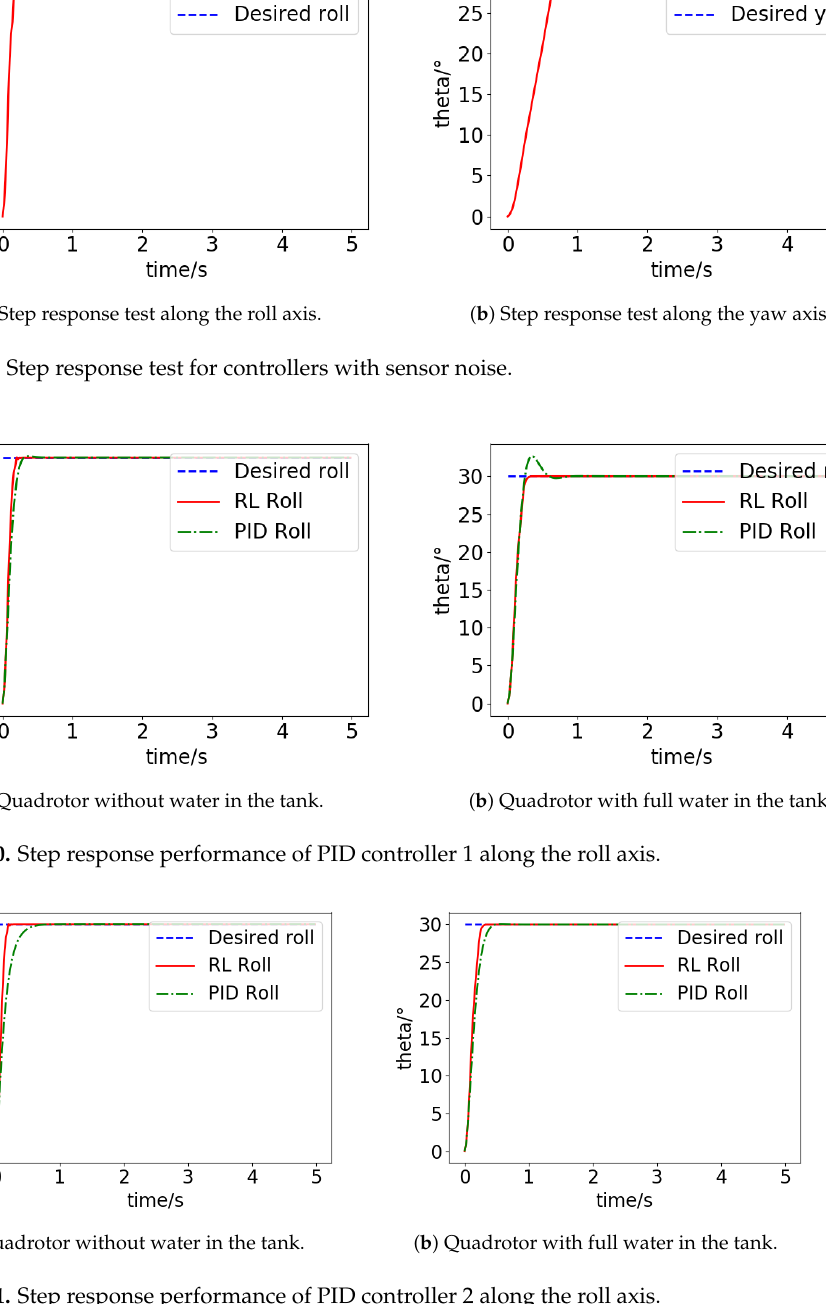
Figure 11. Step response performance of PID controller 2 along the roll